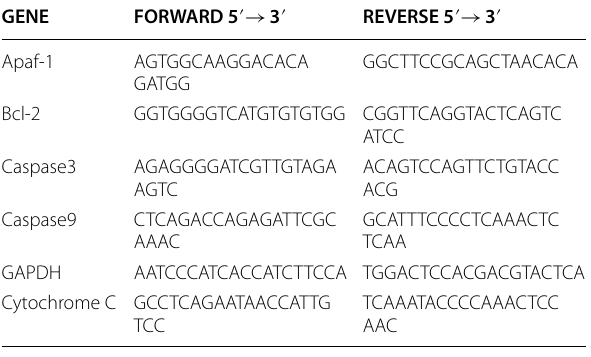
Table 1 Primer sequences used in the qPCR experiment GENE FORWARD 5 ʹ